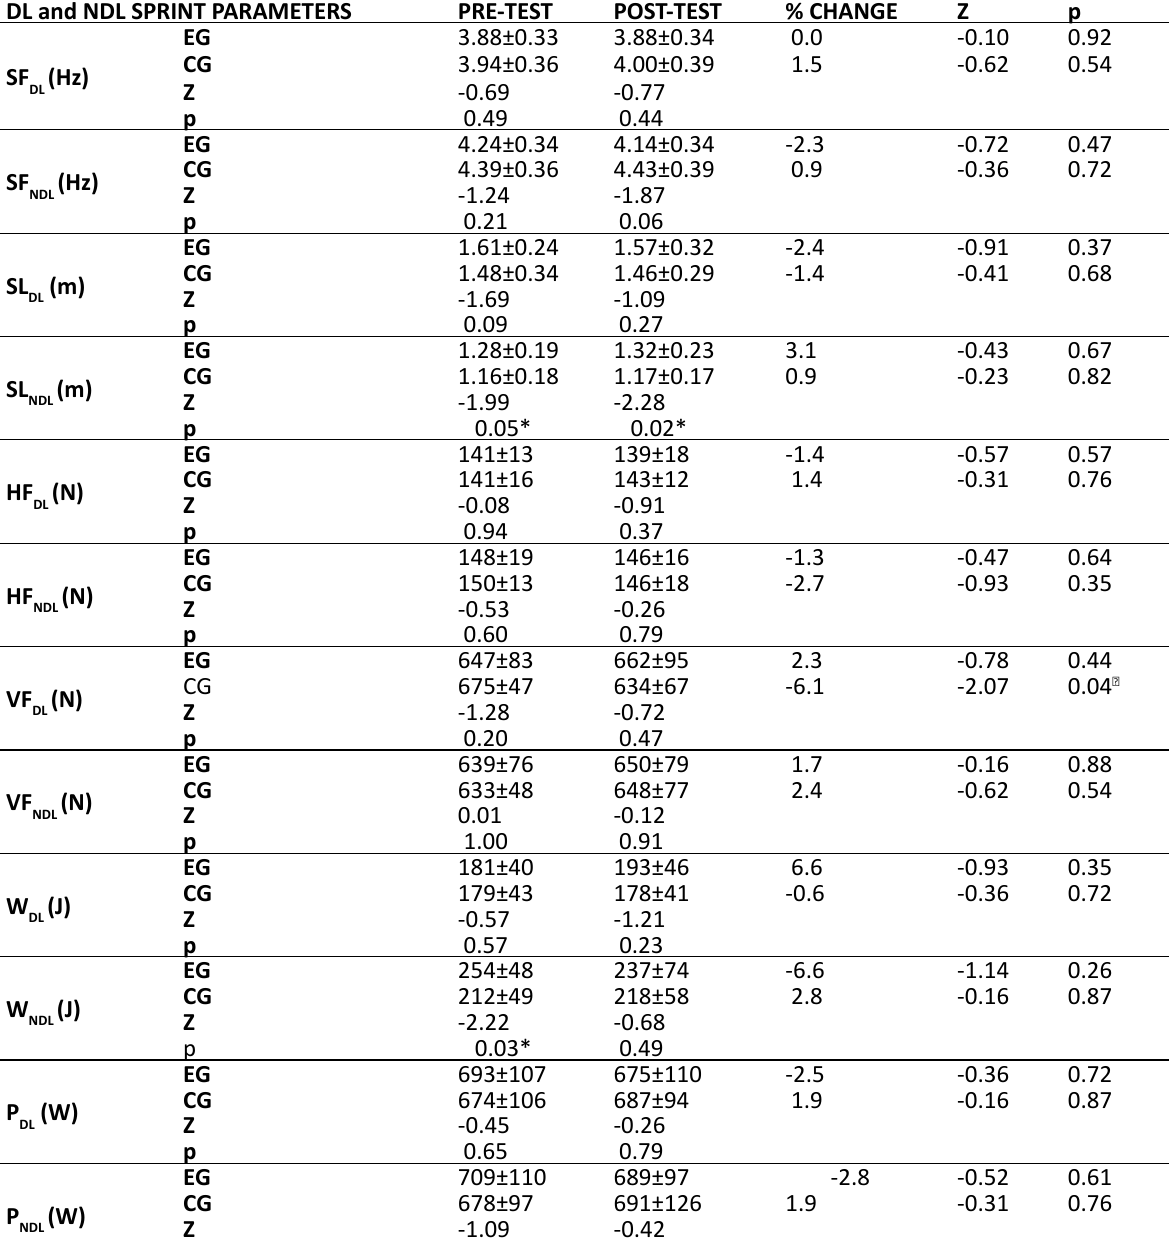
Table 4. Pre- and post-test results of 30m DL and NDL sprint parameters DL and NDL SPRINT